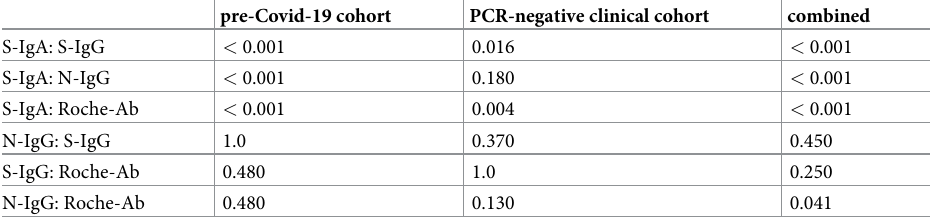
The immunoassay with lower specificity is mentioned